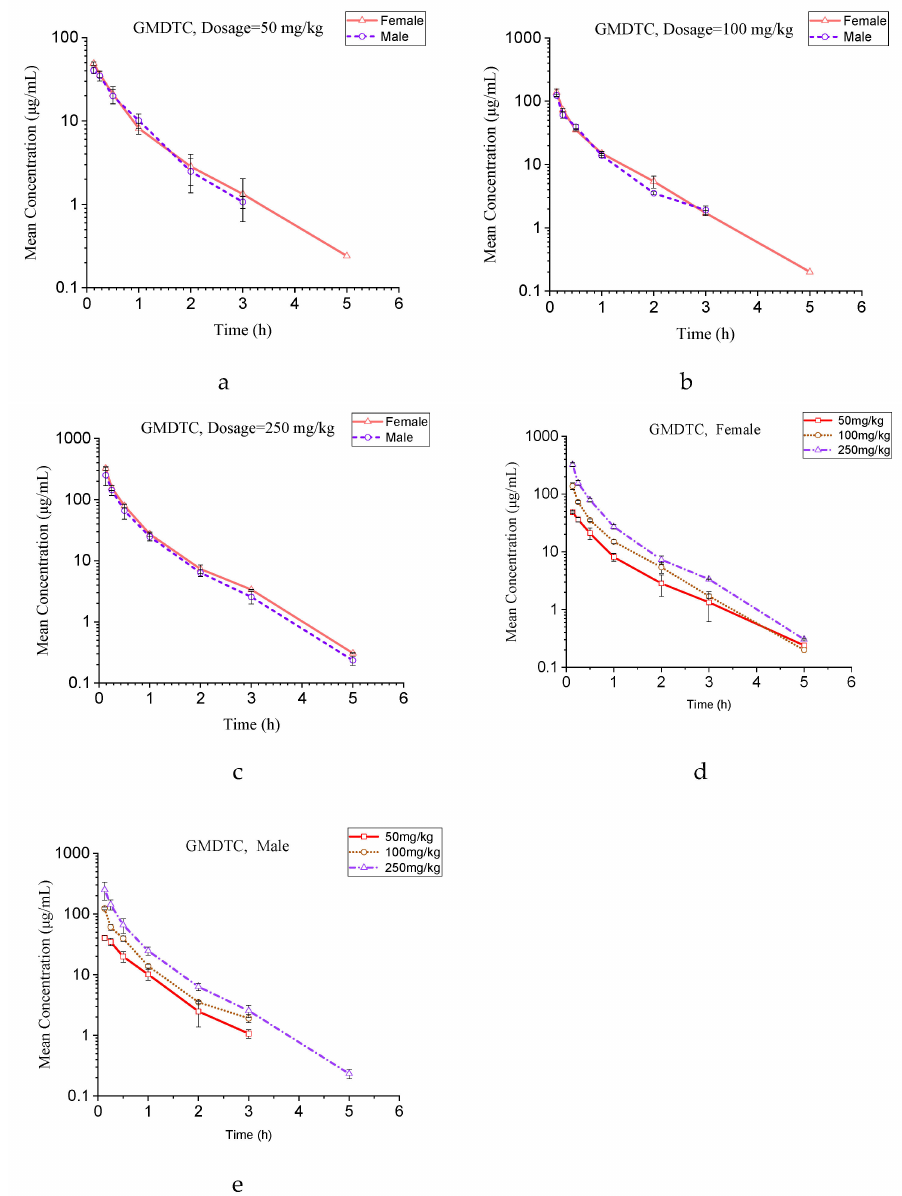
Figure 2. ( a ) Concentration–time curve of GMDTC in plasma of male and female rats at 50 mg/kg. ( b ) Concentration–time curve of GMDTC in plasma of male and female rats at 100 mg/kg. ( c ) Concentration–time curve of GMDTC in plasma of male and female rats at 250 mg/kg. ( d ) Concentration–time curve of GMDTC in plasma of female rats at dosages of 50, 100 and 250 mg/kg. ( e ) Concentration–time curve of GMDTC in plasma of male rats at dosages of 50, 100 and 250